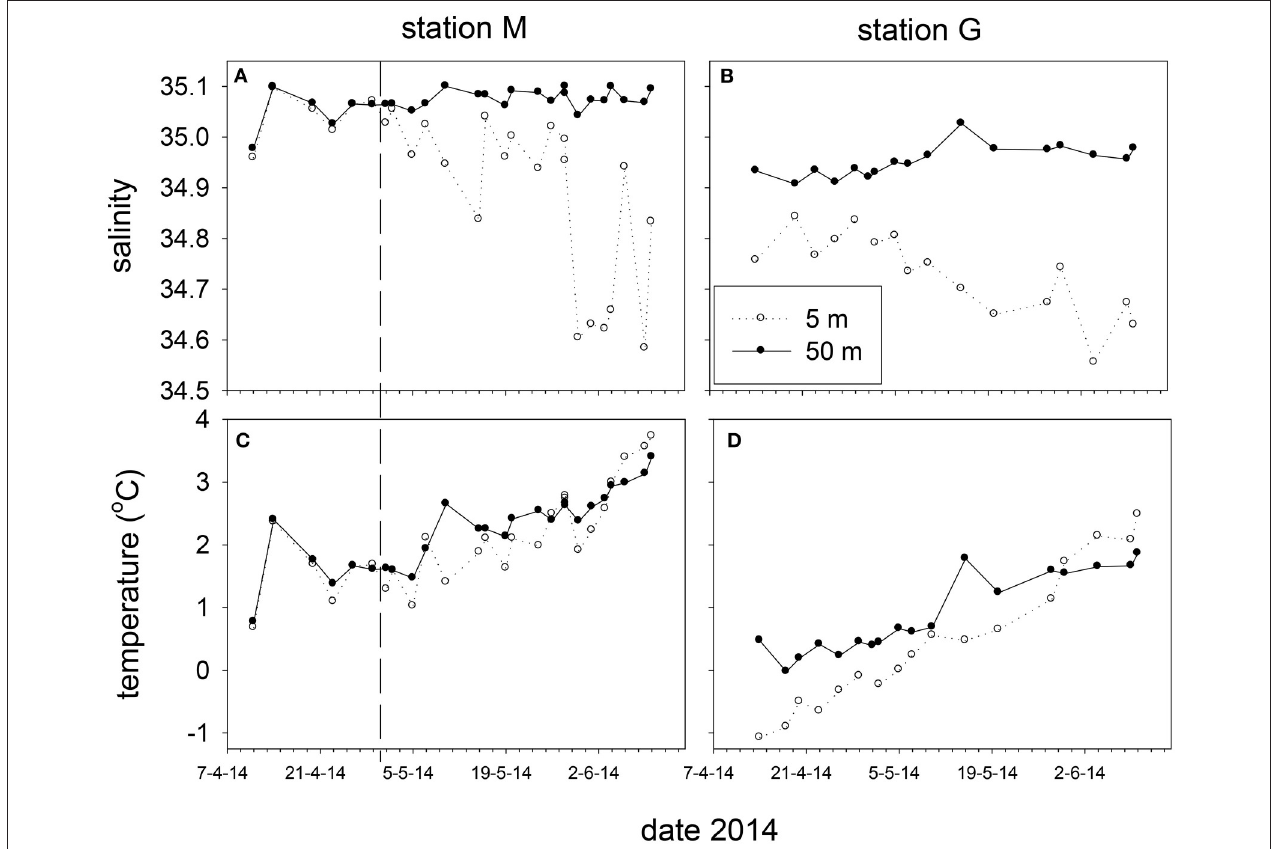
FIGURE 4 | Salinity (A,B) and temperature (C,D) at 5 and 50m depth at station M and G between April and June 2014. The vertical dashed line marks the transition from non-stratified to stratified conditions at station M.